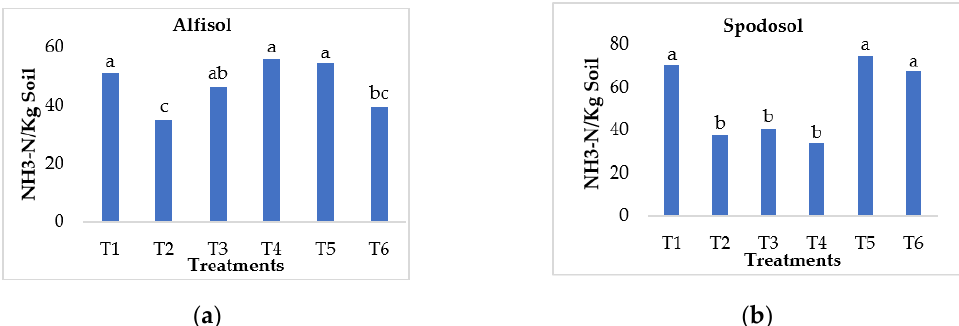
Figure 7. Effect of treatments on cumulative NH 3 volatilization from ( a ) Alfisol soil and ( b ) Spodosol soil. Means with different letters indicate significant differences among treatments by Tukey’s test at p ≤ 0.05.